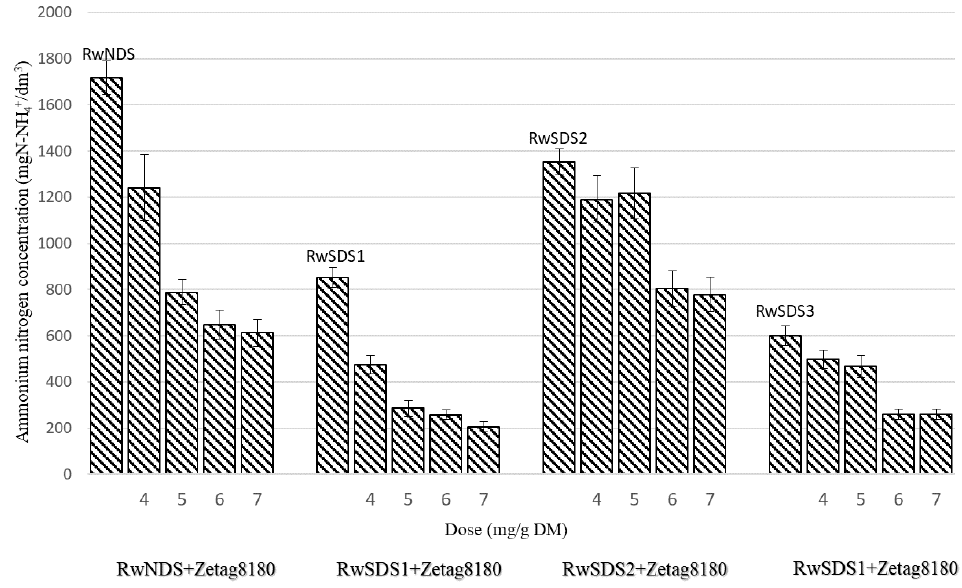
Figure 7. Changes of the ammonium nitrogen concentration in reject water separated from sludge prepared with Zetag 8180.